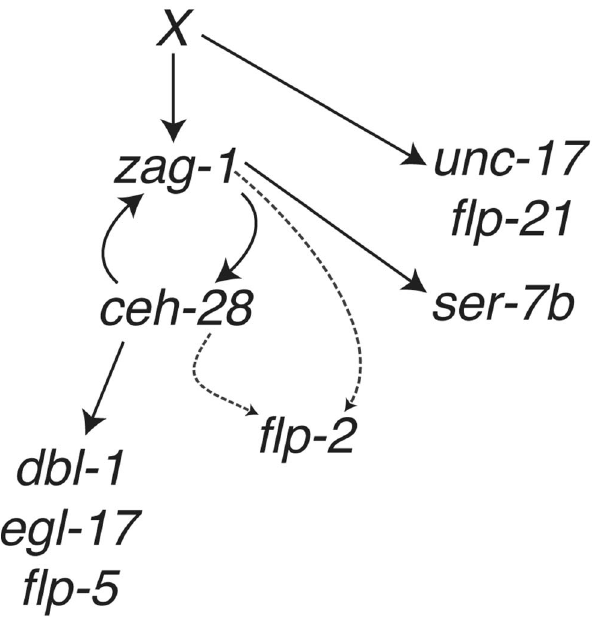
Figure 5. zag-1 and ceh-28 function in a hierarchy in the M4 neuron. Model indicating gene regulatory interactions in M4 discussed in the text. CEH-28 is necessary to activate expression of dbl-1 , egl-17 , and flp-5 . CEH-28 also activates zag-1 gene expression in a positive feedback loop. Either CEH-28, ZAG-1 or both activate flp-2 expression (dashed arrows). ZAG-1 functions upstream to activate ceh-28 and ser-7b expression, while another factor(s) activate zag-1 , unc-17 , and flp-21 (indicated as